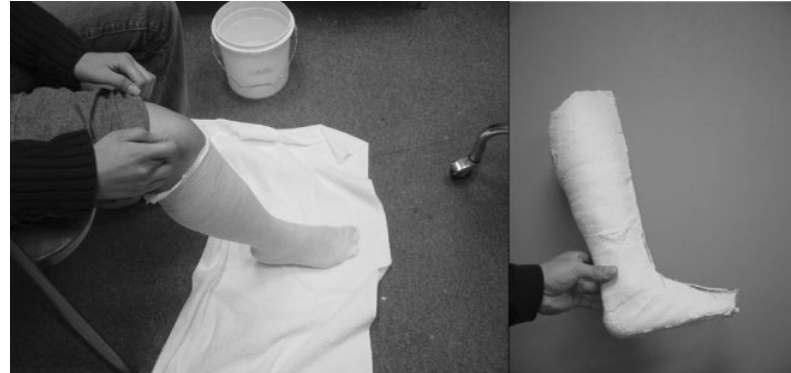
Figure 1 A conventional ankle orthotic fitting.